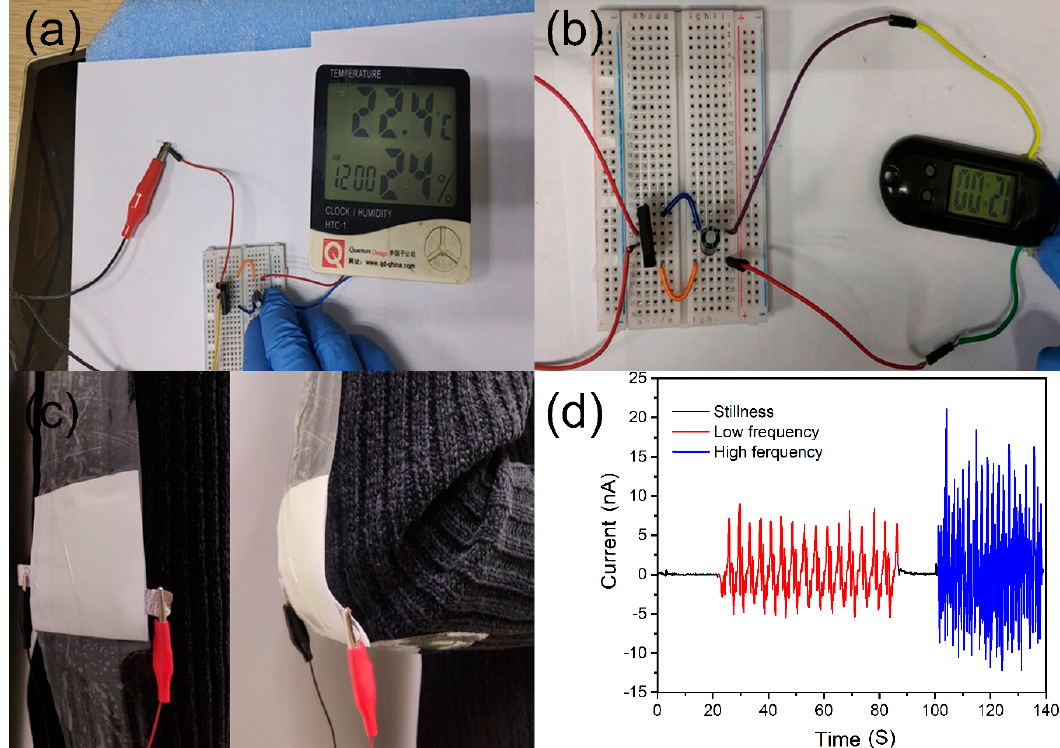
Figure 6. Electronic devices driven by NG, such as ( a ) temperature-humidity sensor, ( b ) electric watch. ( c ) Photograph of the device fixed to an elbow, and ( d ) the output currents generated by arm swinging at low frequency and high frequency.